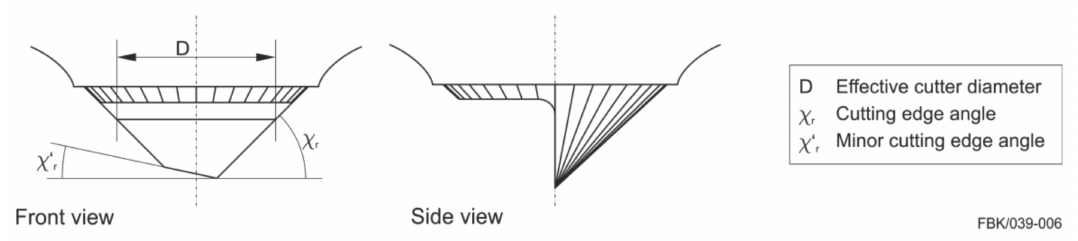
Figure 1. Geometry of a single edge micro end